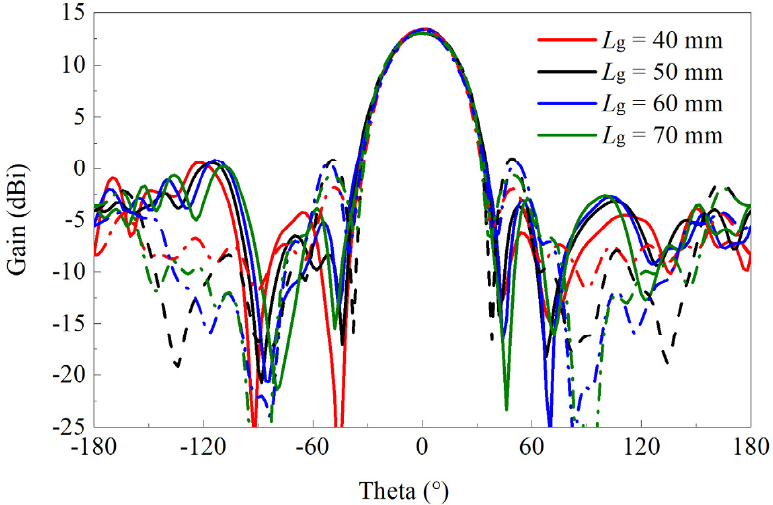
Figure 8. The influence of the ground plane on the radiation patterns. The solid and dashed lines refer to x - z and y - z planes, respectively.